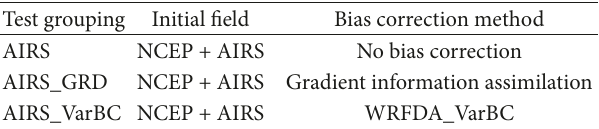
Figure 12: Tracks of TC from experiments and best track provided by CMA-STI (OBS). Table 3: Schemes of numerical test.